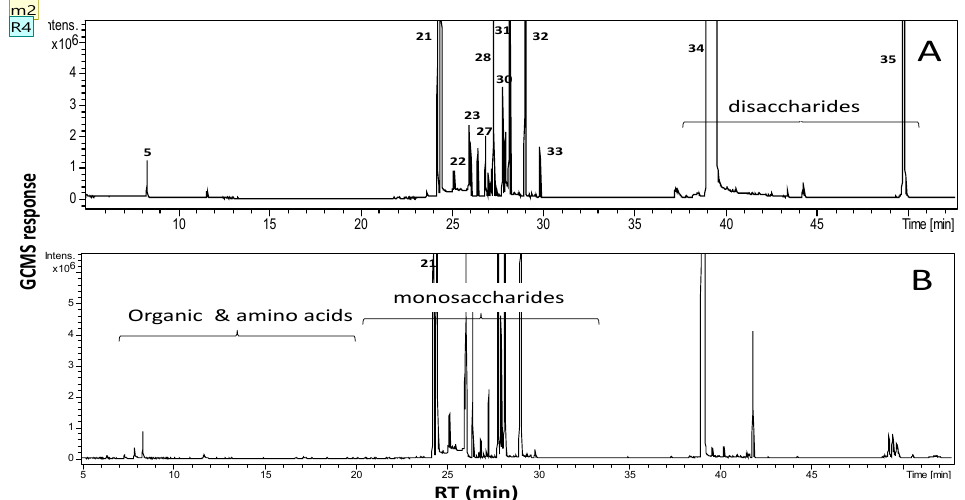
Figure 3. GC/MS chromatograms of silylated metabolites derived from sugarcane juice ( A ) and molasses ( B ) showing major peaks for sugars mono and disaccharides in both extracts.